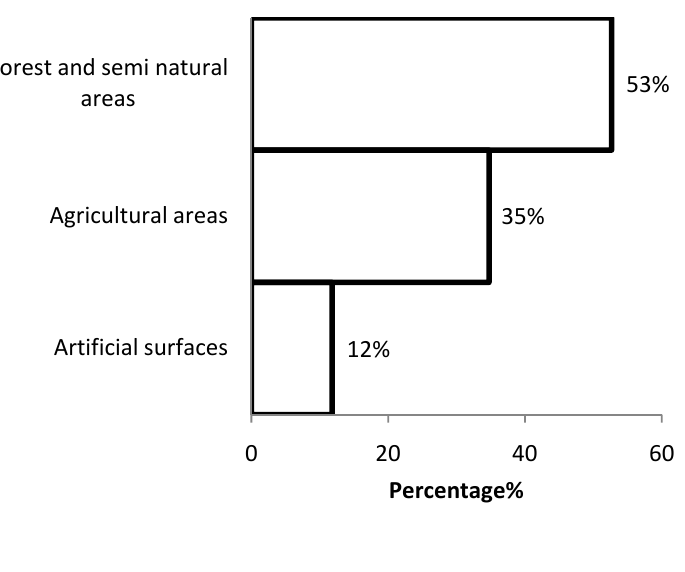
Figure 5. The distribution of the potential habitable areas of the bank voles based on the CORINE land cover category